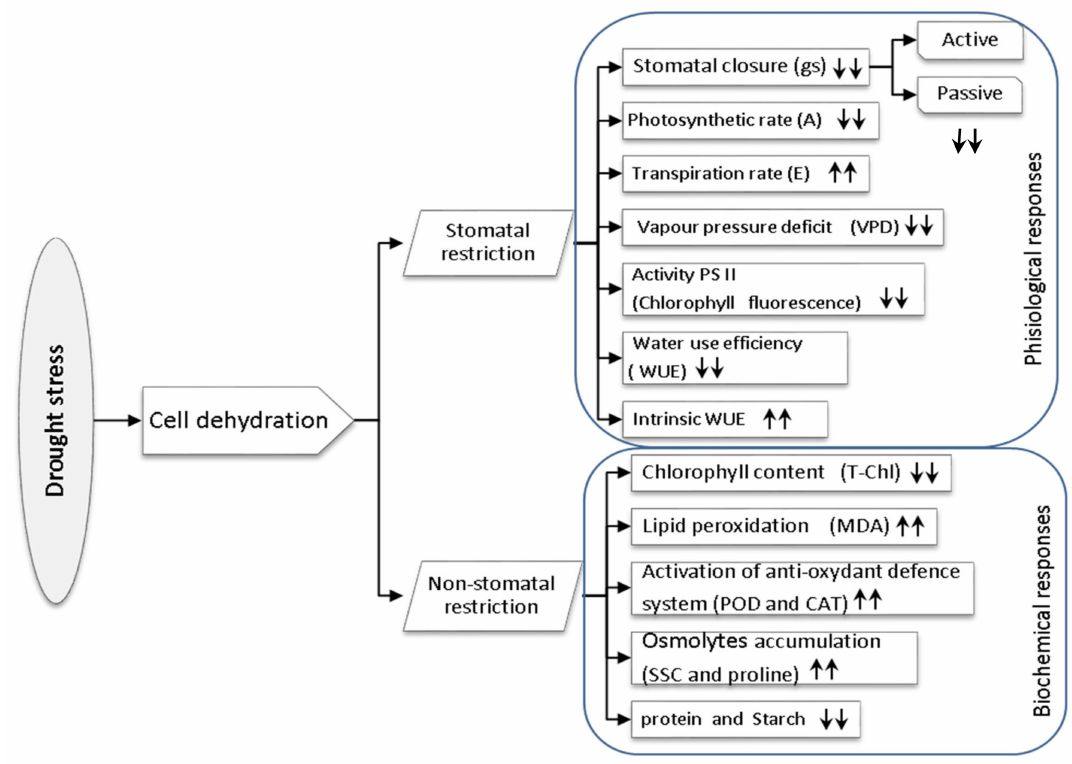
Figure 5. Drought tolerance mechanism flowchart on physiological and biochemical responses basis in plants. Source: developed